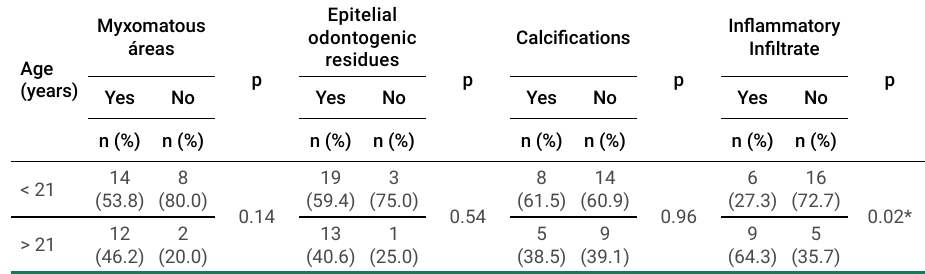
Table 2. Association between the histological characteristics of samples and the age